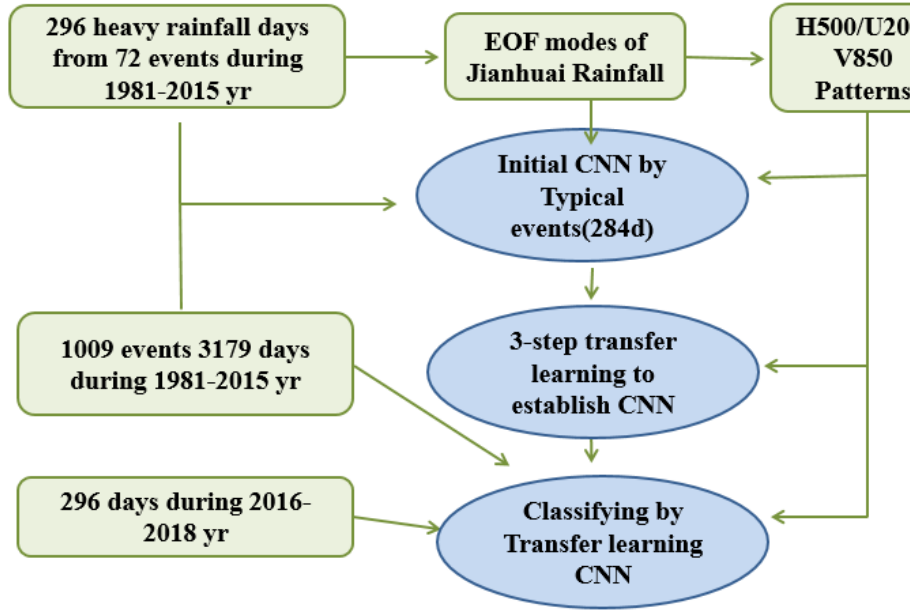
Figure 5. Frame of training for the multi-level transfer learning CNN model. From the loss function and accuracy rate of the model training (Figure 6), the loss function and accuracy rate of the training converge quickly and reach stability. For the testing, the loss function gradually decreases as the accuracy rate gradually increases. The loss function of the transfer learning CNN for the three-level circulation classification